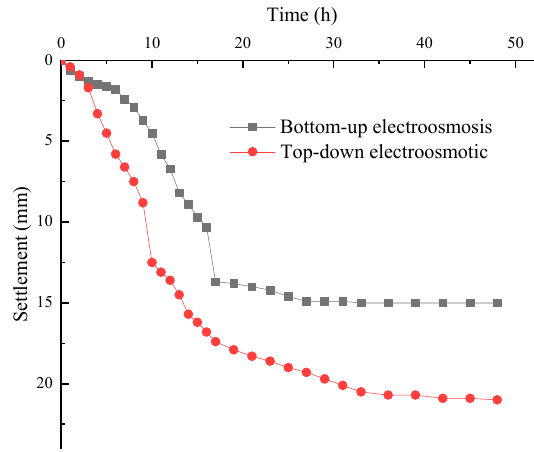
Figure 12. Variation curve of soil surface settlement with time.